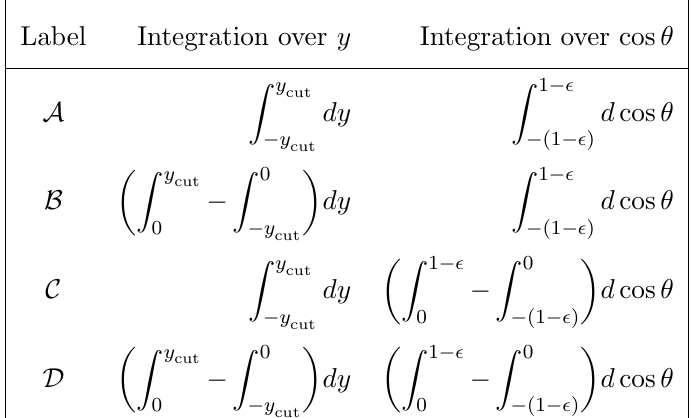
Table 1 . The 4 di(cid:11)erent approaches labelled rapidity y and the polar angle cos (cid:18) in the di(cid:11)erential cross section of eq. (3.12). A value of y p ln s= ^ s ; see eq. (3.14). A smaller value can be also chosen for y be determined according to experimental conditions.